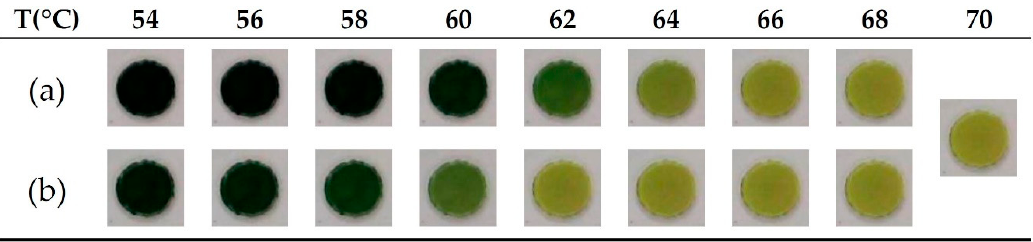
Figure 4. Intensity variation of 3pi thermo-chromatic sheet (TOCS) with temperature during ( a ) initial heating step and ( b ) the cooling step.